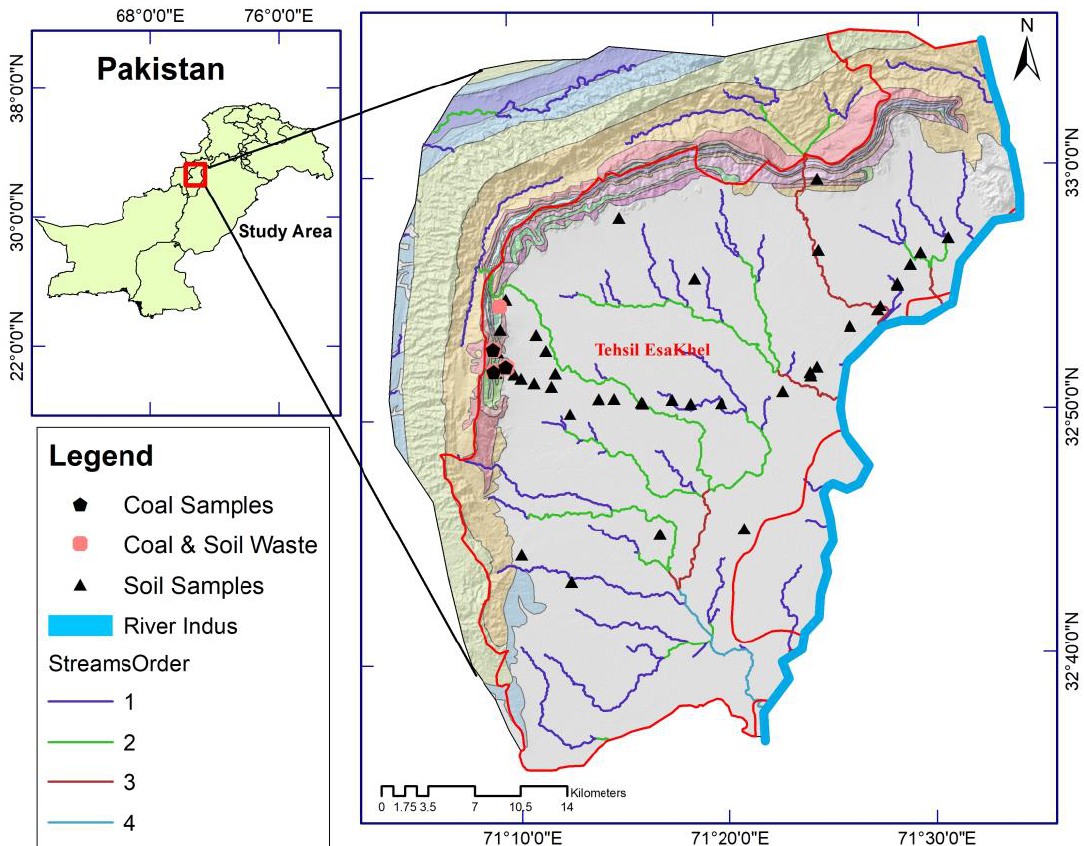
Figure 1. Location map of the study area showing the locations of the coal mines and soil samples.